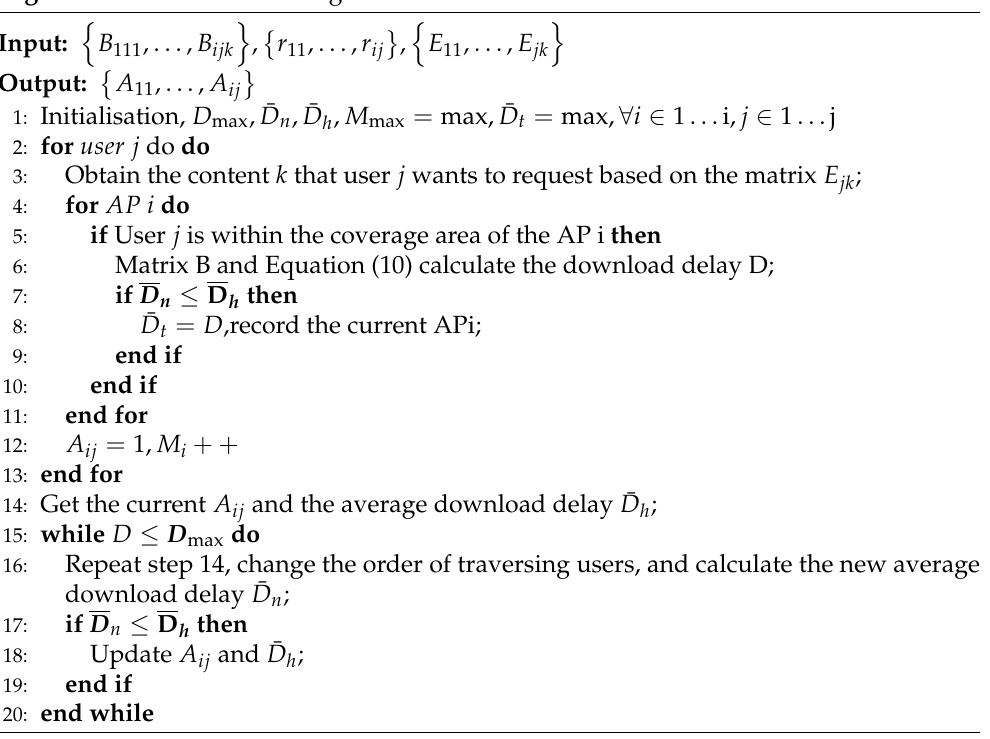
Algorithm 1 AP association algorithm for VR user behavior